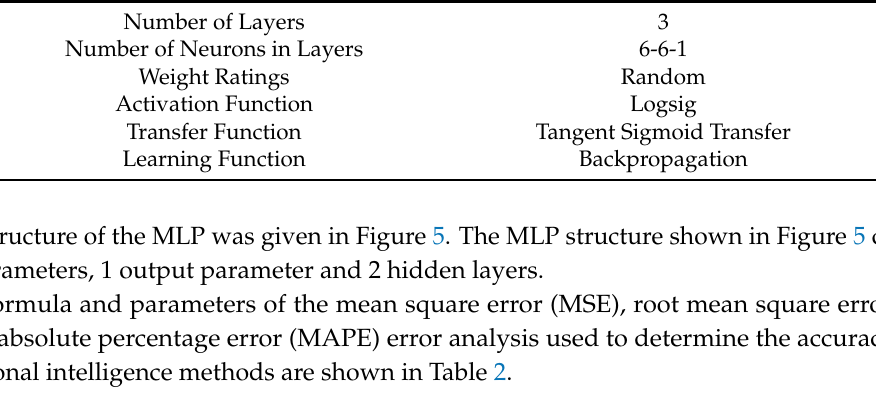
Table 1. The network Structure of multilayer perceptron (MLP).